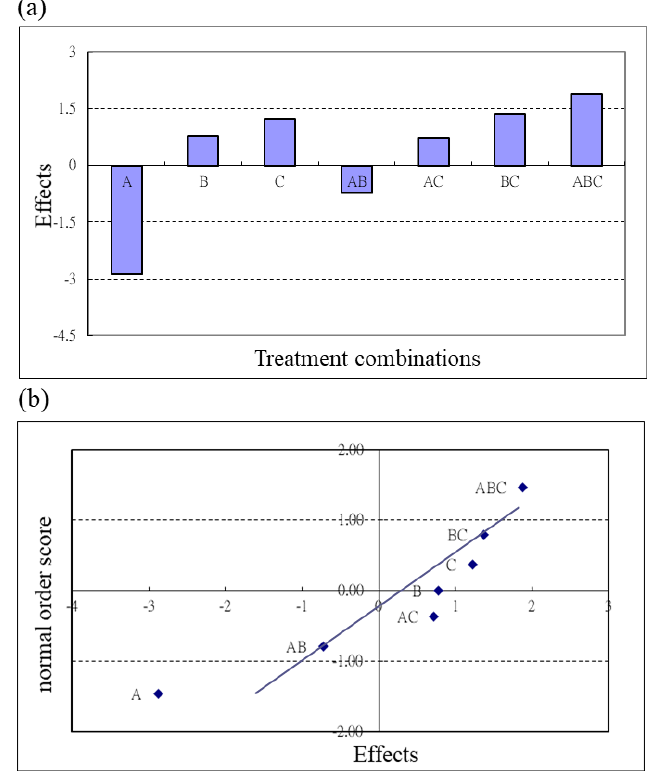
Figure 5. Results of the second factor screening (2 3 factorial run): ( a ) effects versus treatment combinations, and ( b ) normal plot.